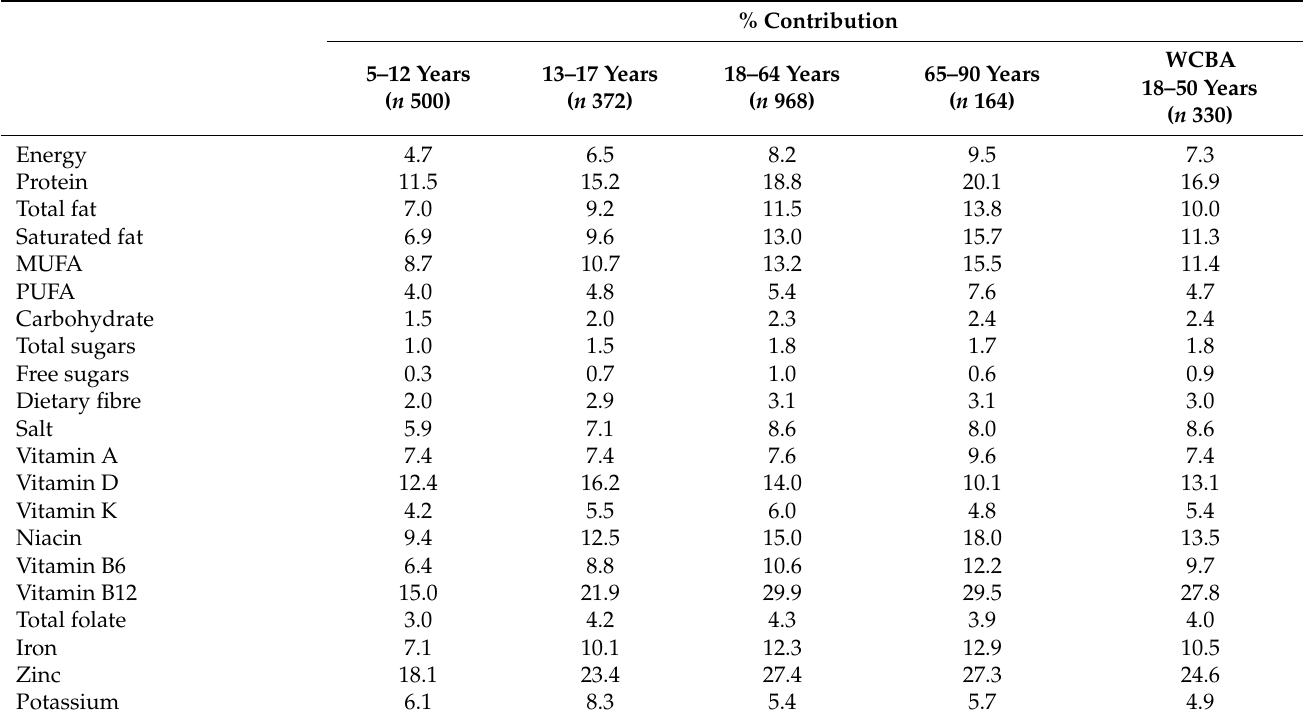
Table 2. Contribution (%) of ‘fresh beef and lamb’ to mean daily intakes of energy and selected nutrients from all sources (including nutritional supplements) in consumers only aged 5–90 years, by age